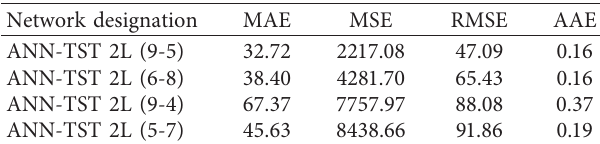
Table 5: Error metrics of top four artificial neural networks on testing